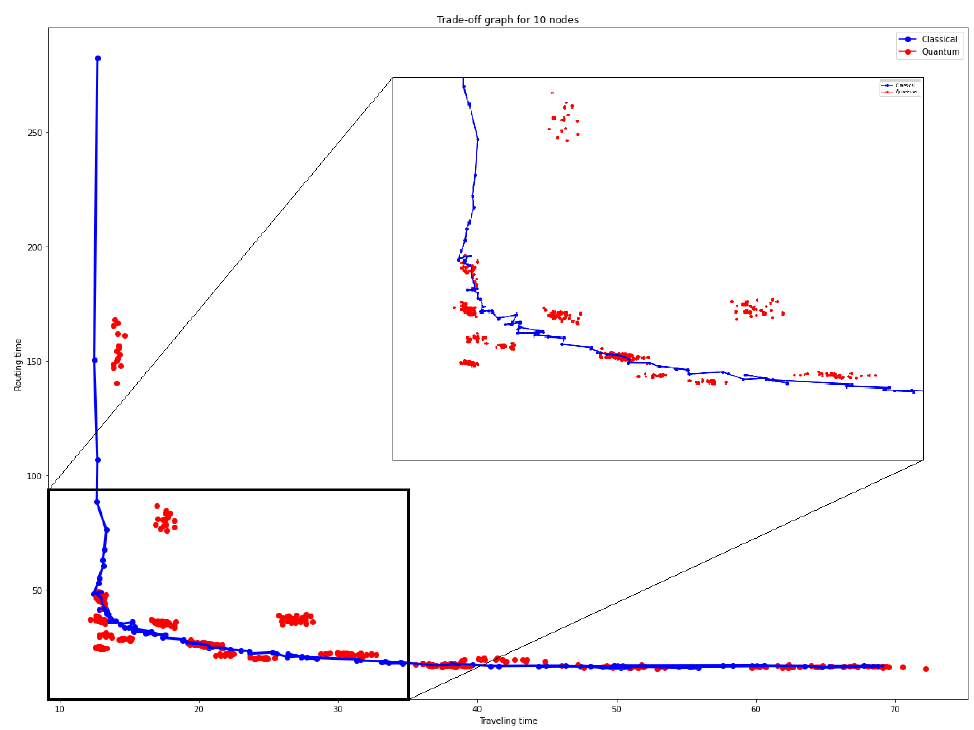
Figure 9. Trade-off barrier broken by quantum protocol. In red different pure quantum strategies, in blue different mixed classical strategies with p values between 0 and